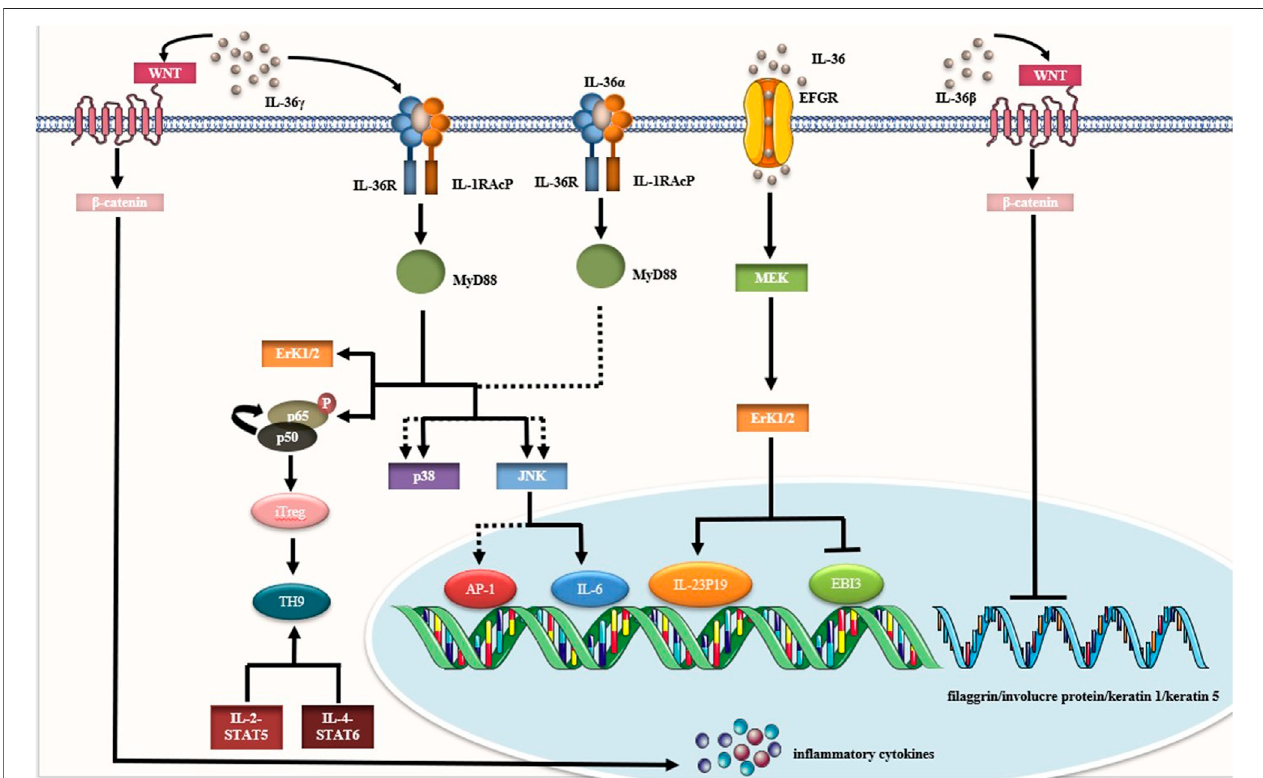
FIGURE 2 | IL-36 ligands induced different signaling pathways, which may promote or inhibit pro-in fl ammatory response. Common signaling pathways included JNK, MEK-ERK, MAPK-p38, Wnt signaling pathway and so on.